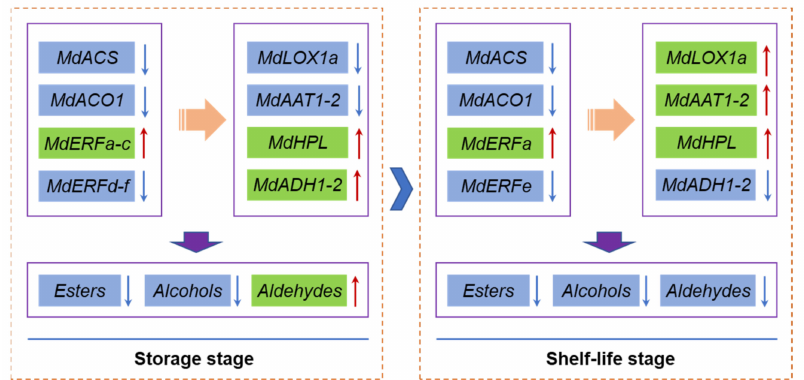
Figure 6. The overall response of the genes related to fatty acid metabolism, and ethylene biosynthesis and signaling in ‘Golden Delicious’ apples during 2 kPa O 2 atmosphere storage and subsequent shelf